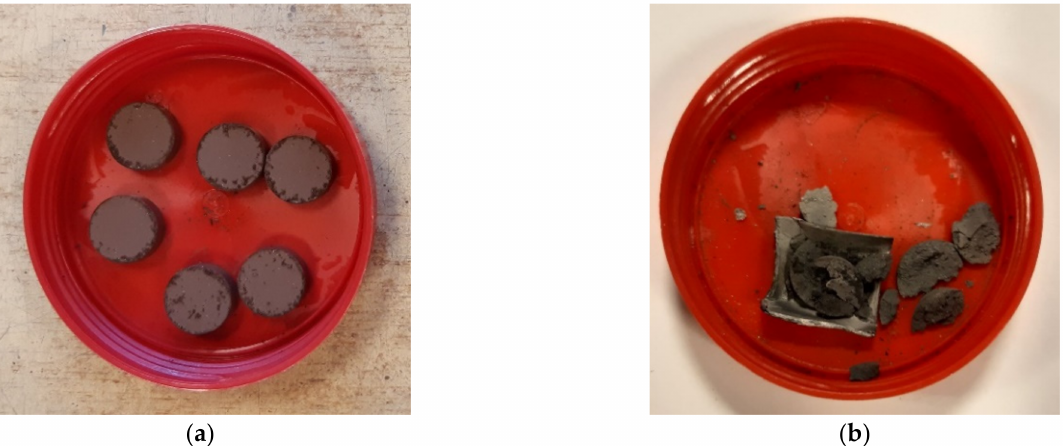
Figure 10. Samples prepared for pressureless sintering ( a ) and sample after pressureless sintering process ( b